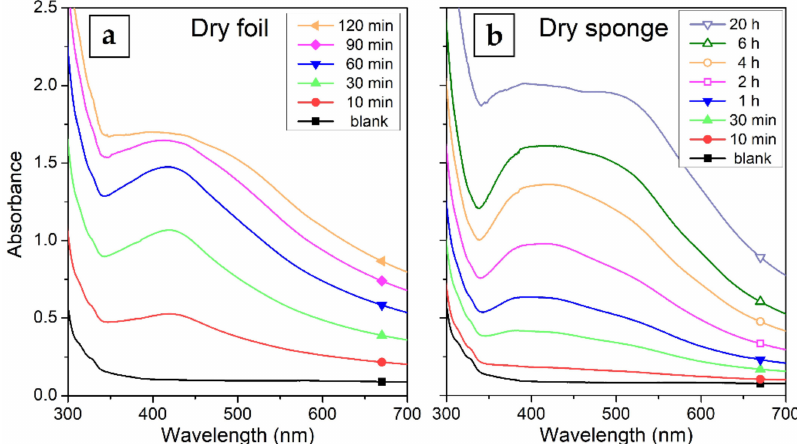
Figure 8. UV–Vis absorption spectra of the solutes taken during the dissolution of the HPMC–AgNP composite: ( a ) dry foil (solutes sampled after 10–120 min dissolution) and ( b ) lyophilized sponge (solutes sampled after 10 min to 20 h of dissolution).